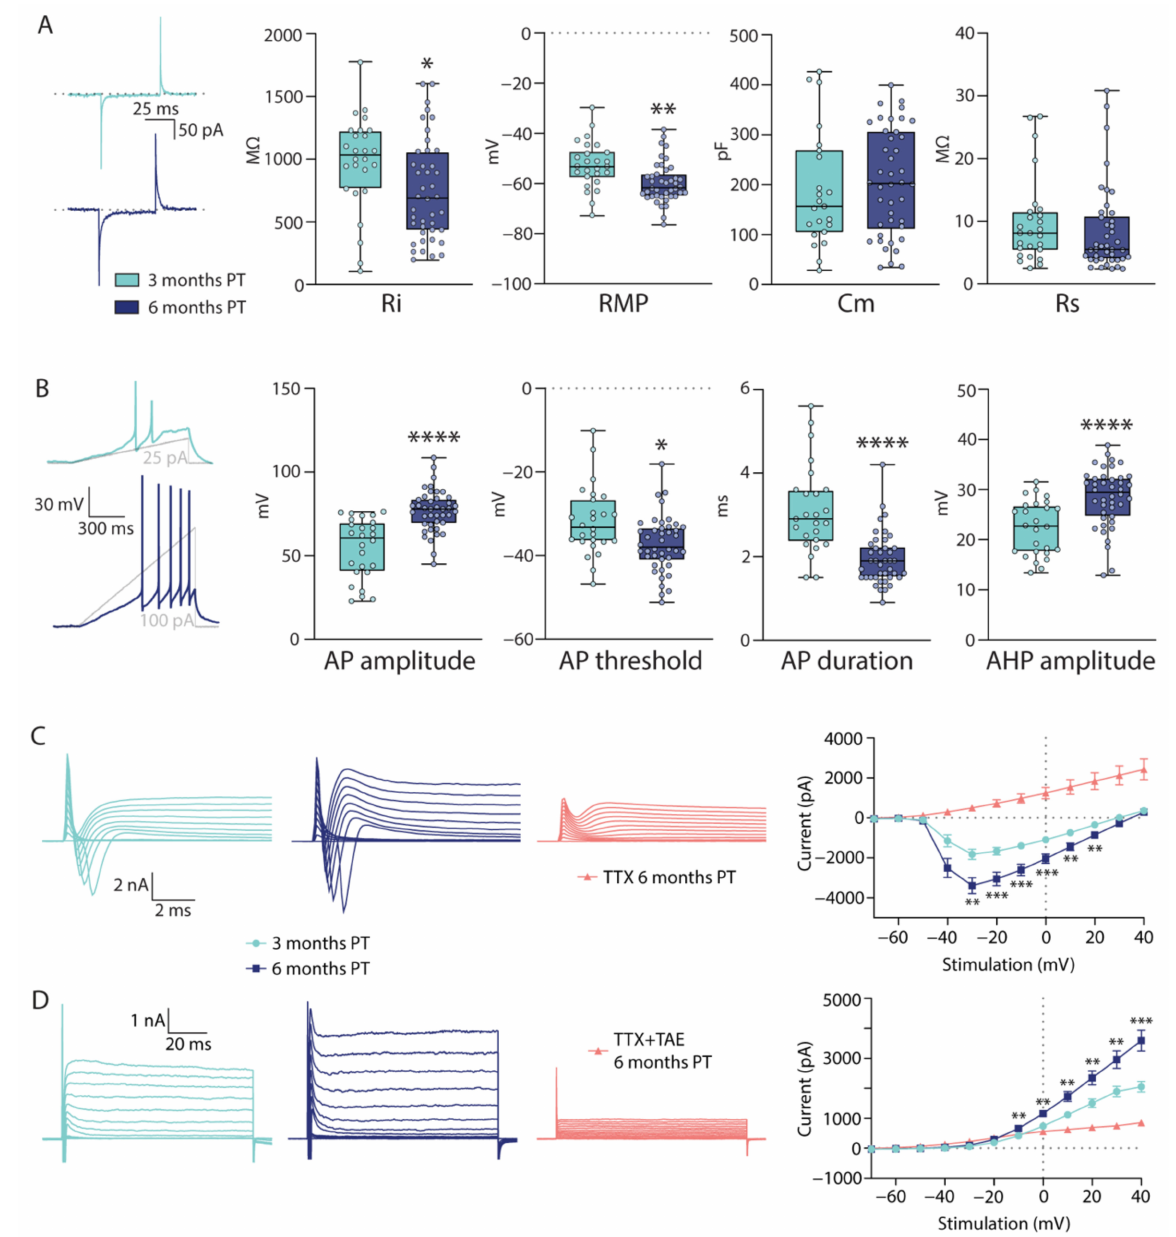
Figure 2. Electric membrane properties of grafted hdInts and their change over time. ( A ) Cell membrane properties of hdInts calculated from a series of 5 mV pulses applied through the patch pipette at three- and six-months PT. The Ri was lower and RMP higher, getting closer to mature neuronal characteristics at the later timepoint. ( B ) AP properties measured from induced APs. All changes between the two time points were significant and indicate neuronal maturation of the grafted cells. ( C ) TTX-sensitive evoked sodium currents were higher at six months PT. ( D ) TAE-sensitive evoked potassium currents were higher at six months PT. *, p < 0.05; **, p < 0.01; ***, p < 0.001; ****, p < 0.0001. Mann-Whitney test was used to compare medians in ( A , B ); Multiple unpaired t -tests were used to compare means in ( C ) and ( D ). Dotted grey line represents the baseline (0 mV/0 pA) from which reported values have been measured. Ri, input resistance; RMP, resting membrane potential; Cm, membrane capacitance; Rs, series resistance; AHP, after-hyperpolarisation; TTX, tetrodotoxin; TAE,